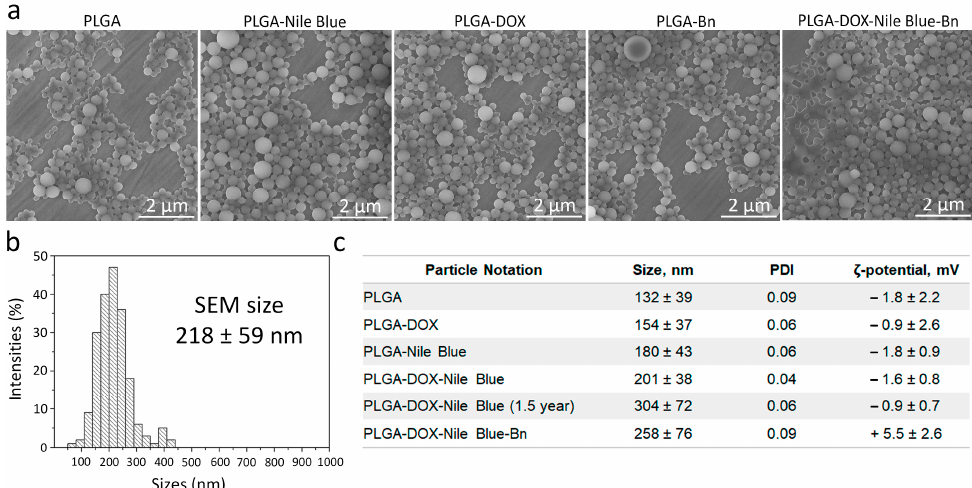
Figure 3. Characterization of PLGA nanoparticles. ( a ) Scanning electron microscopy analysis of pristine polymer nanoparticles (PLGA), particles loaded with Nile Blue only (PLGA-Nile Blue), particles loaded with doxorubicin only (PLGA-Dox), particles conjugated with barnase (PLGA-Bn), particles loaded with doxorubicin, Nile Blue and conjugated with barnase (PLGA-DOX-Nile Blue-Bn). ( b ) The physical size distribution of nanoparticles loaded with Nile Blue and doxorubicin is obtained by image processing. ( c ) Hydrodynamic sizes, polydispersity indices, and ζ -potentials of pristine PLGA nanoparticles, particles loaded with doxorubicin only (PLGA-Dox), particles loaded with Nile Blue only (PLGA-Nile Blue), particles loaded with doxorubicin and Nile Blue (PLGA-Dox-Nile Blue), particles loaded with doxorubicin and Nile Blue (PLGA-Dox-Nile Blue) and stored for 1.5 years, particles loaded with doxorubicin and Nile Blue and conjugated with barnase (PLGA-Dox-Nile Blue-Bn).